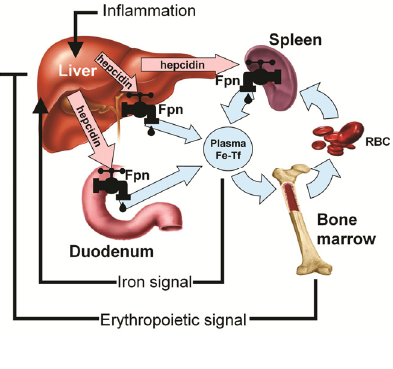
Figure 3. Hepcidin-ferroportin (Fpn) interaction determines the flow of iron into plasma. Hepcidin concentration is in turn regulated by iron, erythropoietic activity, and inflammation [40]. (with permission to publish photo from Blood: Journal of the American Society of